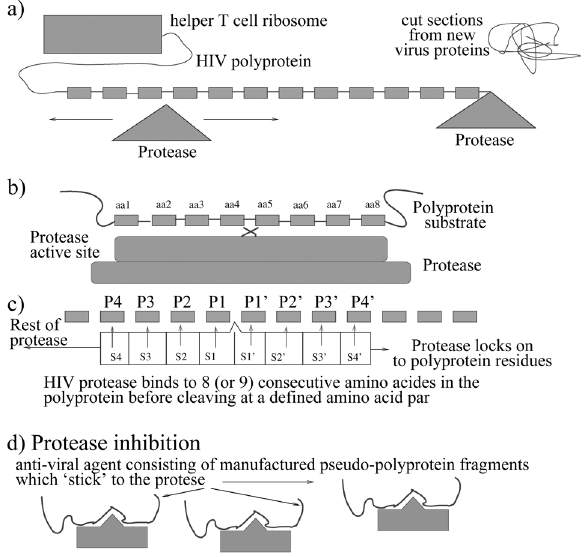
Figure 1 - When the HIV viral polyprotein emerges from the CD4+T cell’s ribosome (a), potential recognition sites (amino acid sequences of length 8) become available to the viral protease for cleavage. If a binding site is found, the protease cleaves the polyprotein (b) after locking on to thepolyprotein(substrate)andcutting(c)attheactivesite.Proteaseinhib- itors (d) are a relatively new form of anti-viral agent, which, through com- petitive inhibition, prevents the protease from further functioning (Narayanan et al. , 2002).